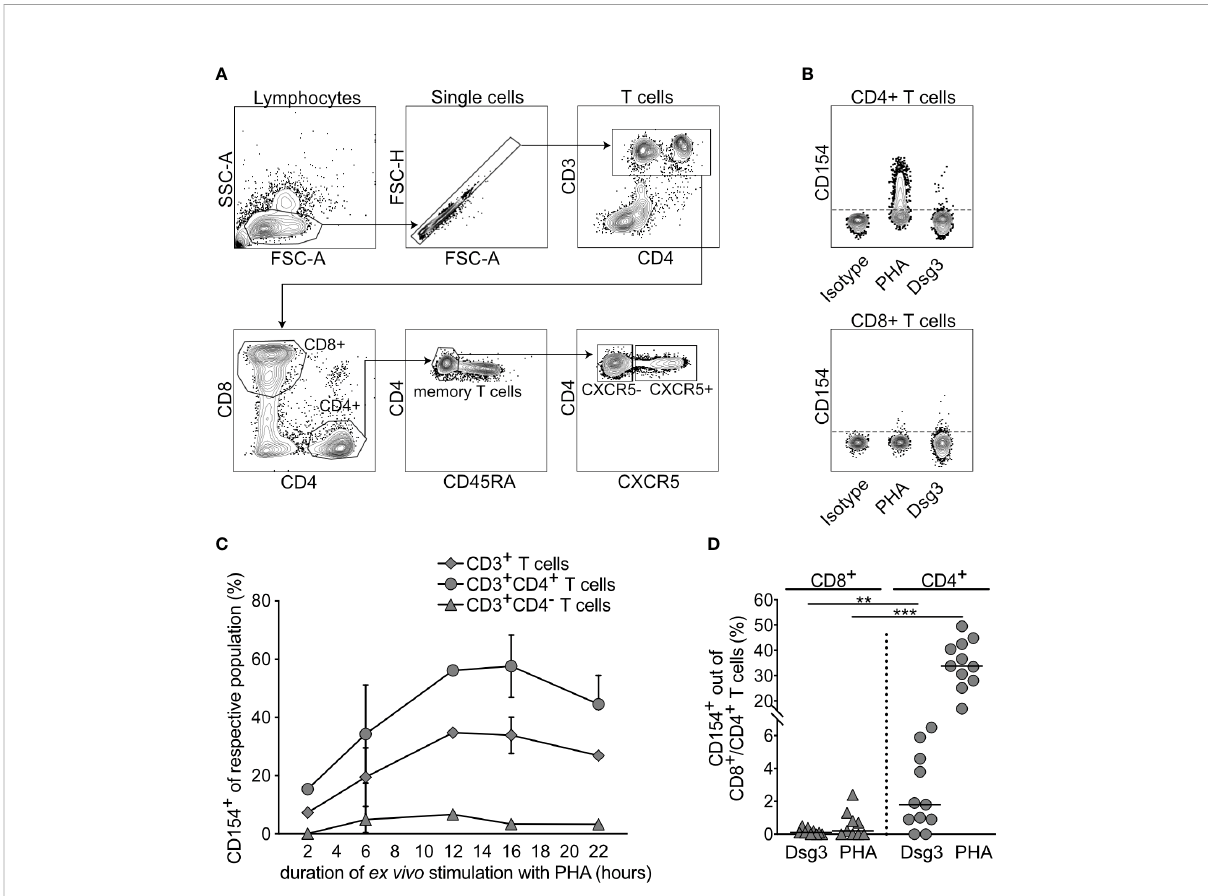
FIGURE 1 CD154 expression of CD3+ T cells and their subpopulations upon ex vivo stimulation. (A) Gating strategy to identify lymphocytes, single cells, T cells in peripheral blood, CD4+ and CD8+ T cells, memory T cells, CXCR5- and CXCR5+CD4+ T cells. FSC-A, forward scatter area; SSC-A, side scatter area; FSC-H, forward scatter height. (B) Representative fl ow cytometry plots portraying CD154 expression by CD4+ T cells upon antigenic (Dsg3) and mitogenic (PHA) ex vivo stimulation for 16 hours. (C) Kinetic analysis of relative CD154 frequency, identi fi ed by fl ow cytometry in peripheral blood, upon polyclonal stimulation out of respective parent population, i.e. CD3+ T cells, CD3+CD4+ T cells, CD3+CD4- T cells, CD3+CD4+CXCR5- T helper and CD3+CD4+CXCR5+T follicular helper cells, respectively. (n=1-3). (D) Relative frequency of CD154 expression on CD8+ and CD4+ T cells in peripheral blood of PV patients upon speci fi c (Dsg3) or nonspeci fi c (PHA) ex vivo stimulation for 16 hours (n=9-11). p<0.01 **, p<0.001